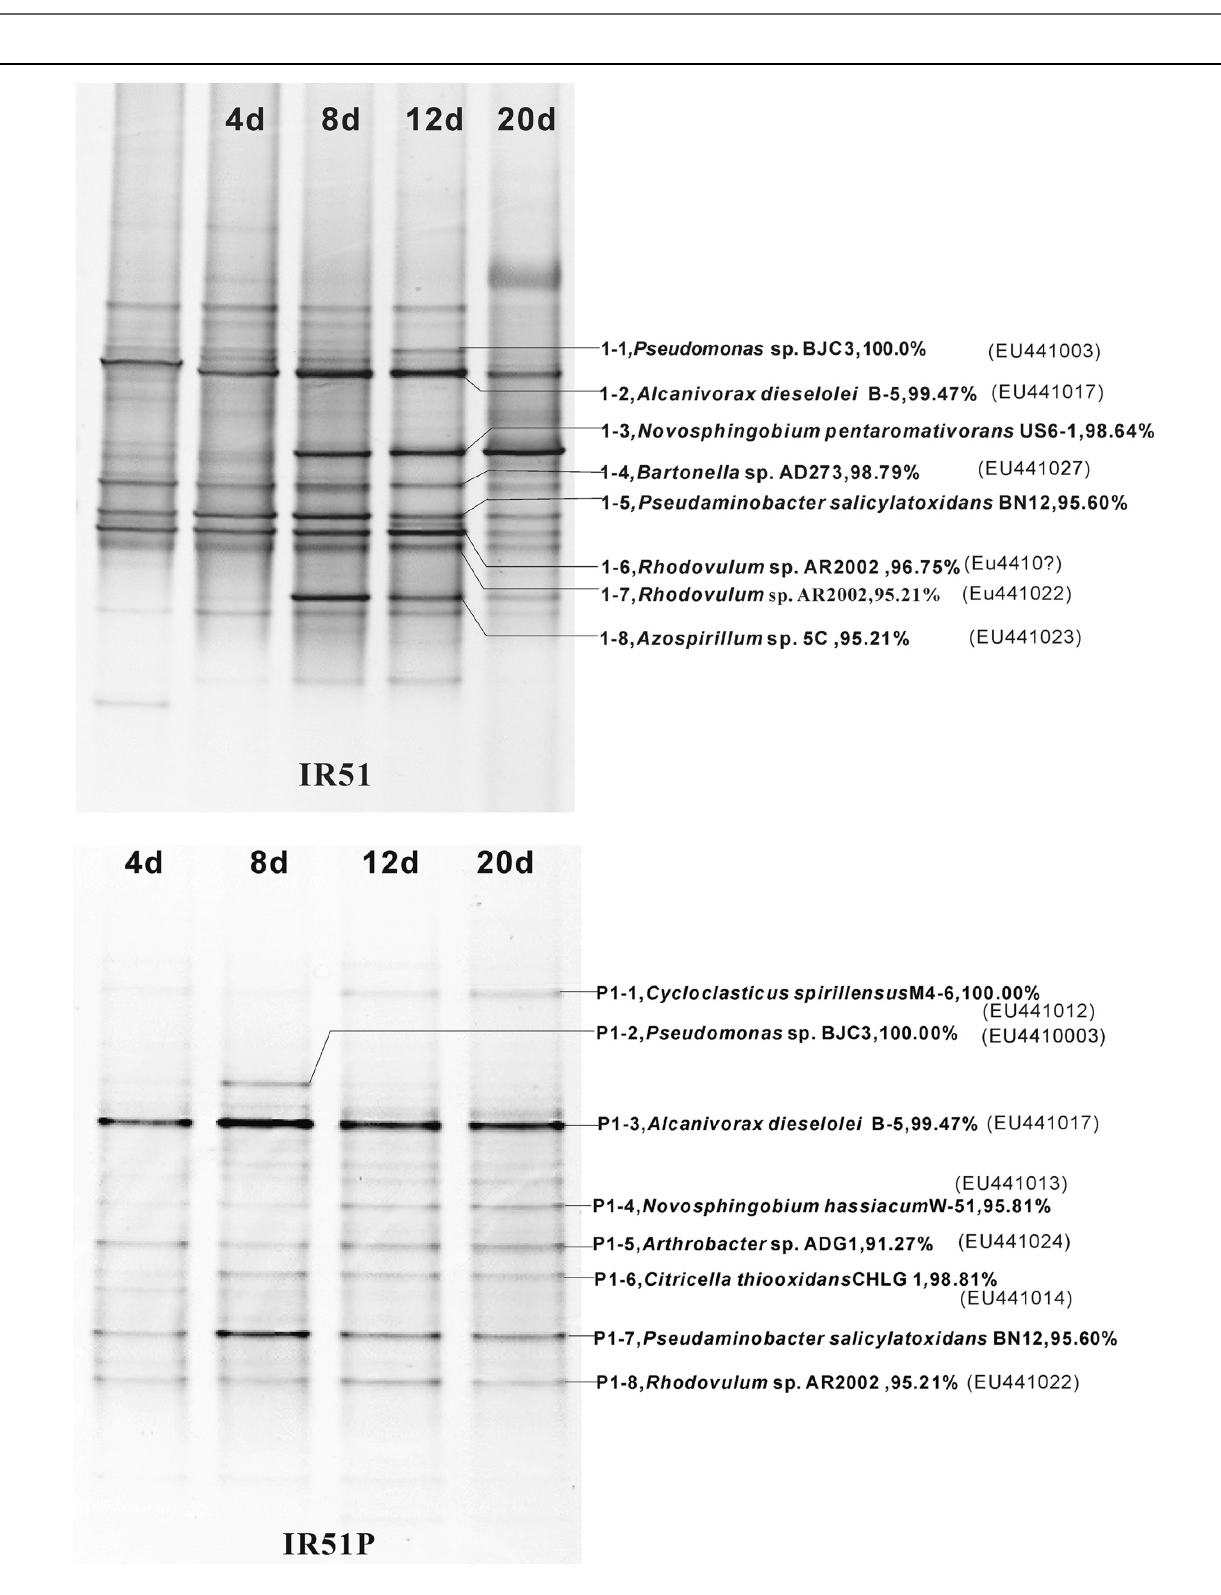
FIGURE 4 | Community structures of the PAH-degrading consortia from 4746 m water depth (20 m to the sea floor). Numbers (4–20 days) above each lane indicate the number of days inoculated. The first lane is the initial